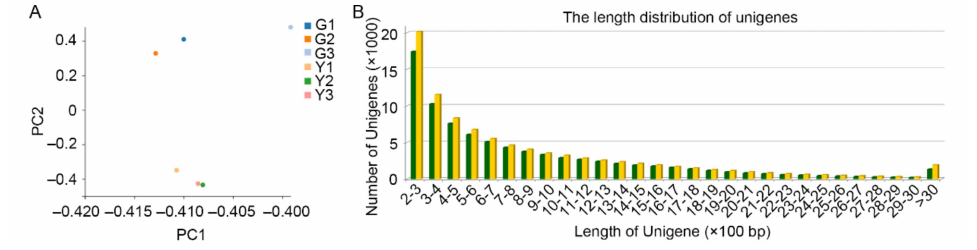
Figure 2. Summary of paired-end sequencing using DNBSEQ platform (MGI). ( A ) Principal compo- nent analysis (PCA) plot for the expression of unigenes in different samples; ( B ) the length distribution of unigenes identified in the transcriptomes of green and yellow tissues.